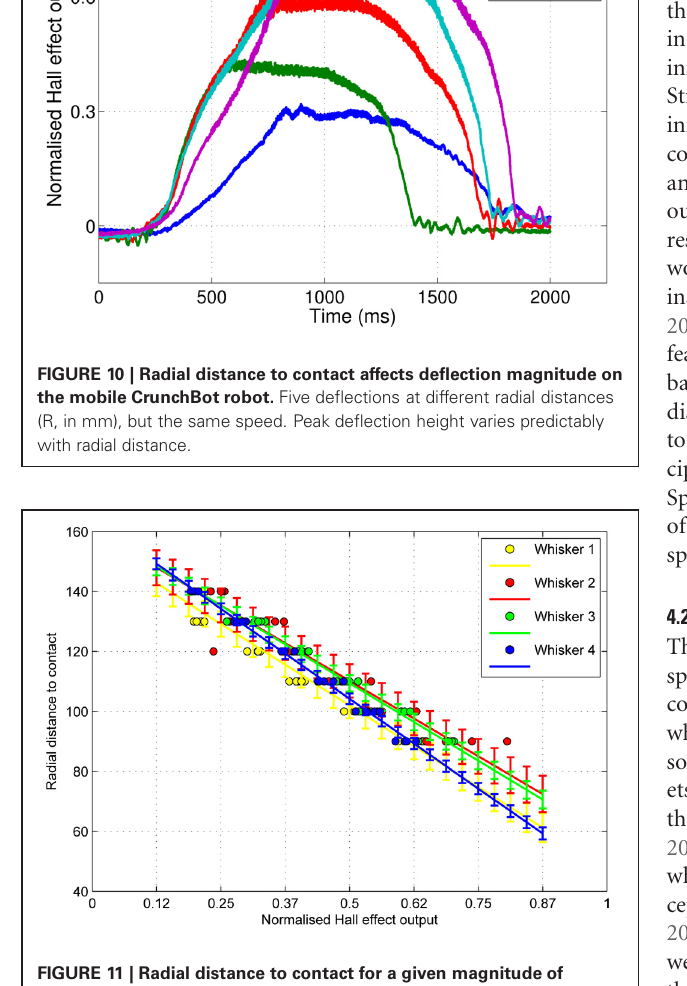
FIGURE 11 | Radial distance to contact for a given magnitude of whisker deflection (dots), and estimates of the standard deviation of the error in predicting future observations (errorbars) for each whisker. Sample size = 30 contacts per whisker, 120 in total. Radius measured in